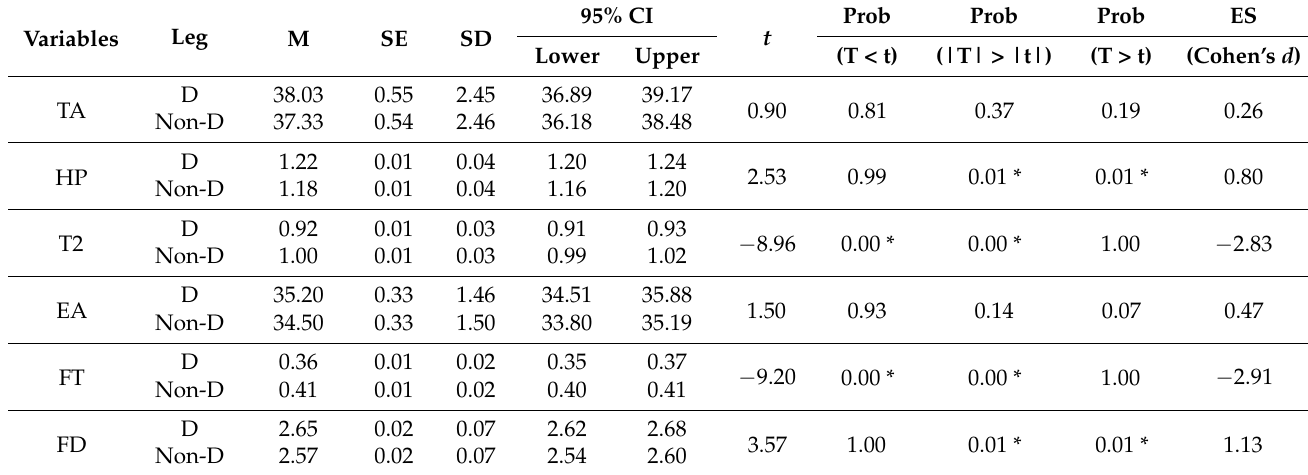
Table 3. Effects of leg dominance on kick-start parameters—flight